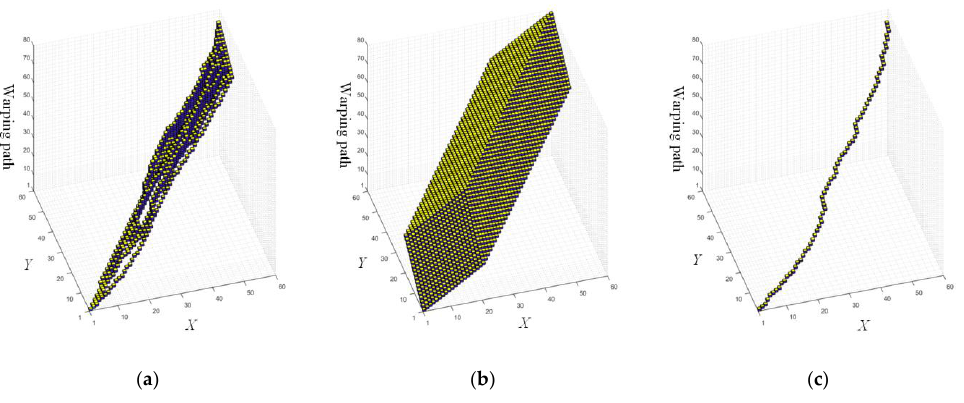
Figure 9. The final ECT ( a ) with pruning and ( b ) without pruning. ( c ) The optimal warping path that extracted from the final ECT.